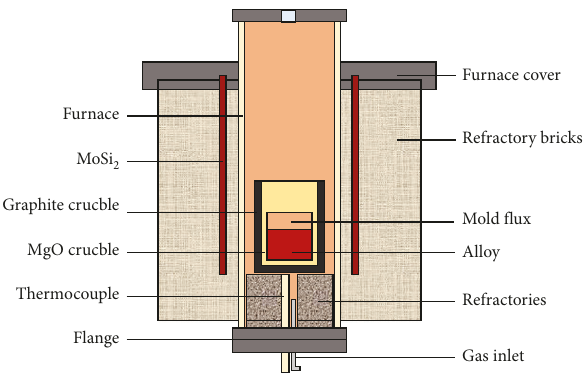
Figure 5: Schematic diagram of the experimental resistance